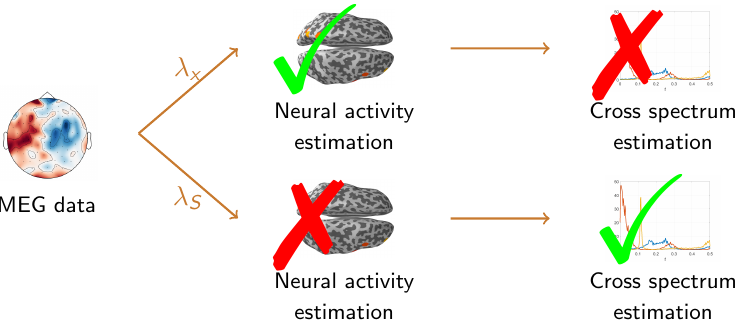
Figure 1. Schematic representation of the differences between the regularization parameter providing the best time series estimate ( λ x ) and the one providing the best cross-power spectrum estimate ( λ S ). The first one provides an optimal reconstruction of the neural activity, but it may not lead to an optimal estimate of the cross-power spectrum; vice versa, λ S provides an optimal reconstruction of the cross-power spectrum at the expense of a sub-optimal estimate of the time